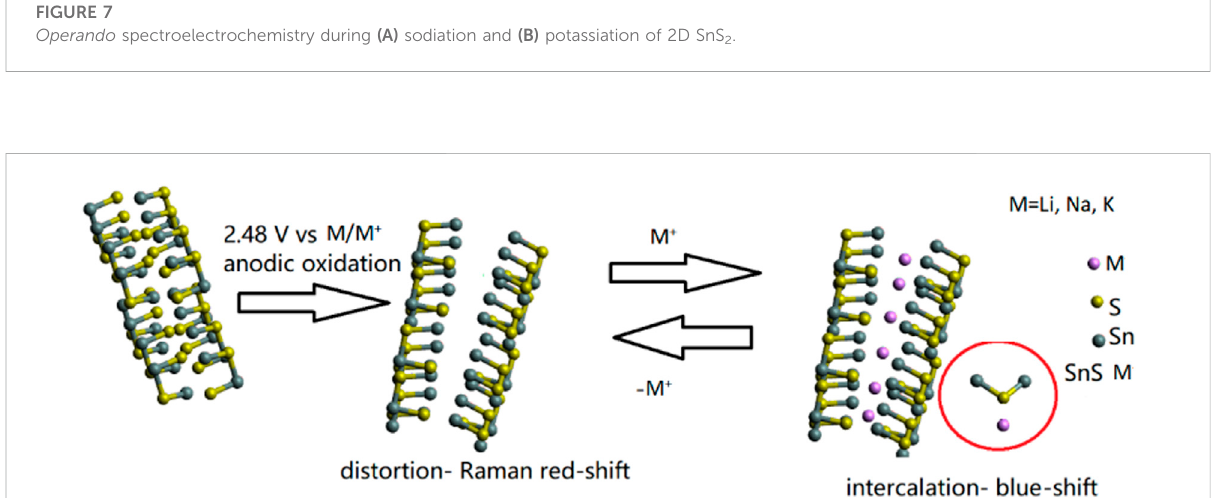
FIGURE 8 Proposed mechanism of SnS 2 lithiation consisting of electrochemical lattice distortion monitored by operando vibrational Raman spectroelectrochemistry, weak ionic lithium accommodation on the sulfur side and deducted from that blue-shift of the translational S-Sn-S mode in the Raman